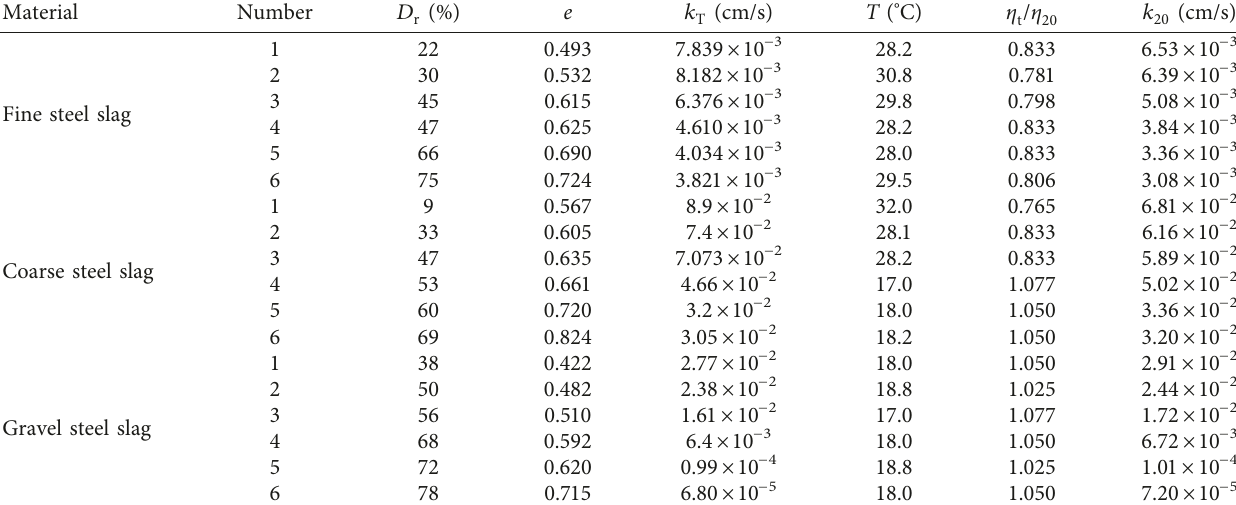
Table 7: Permeability coefficients of three kinds of steel slag at standard temperature. Material